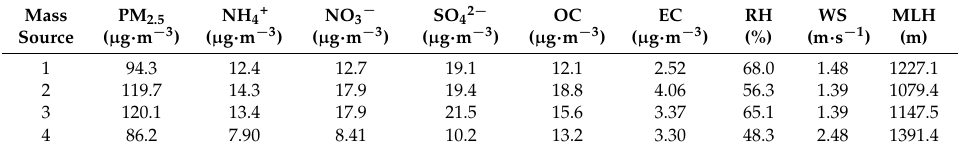
Table 4. Variations of aerosol concentration and meteorological elements from different air masses.